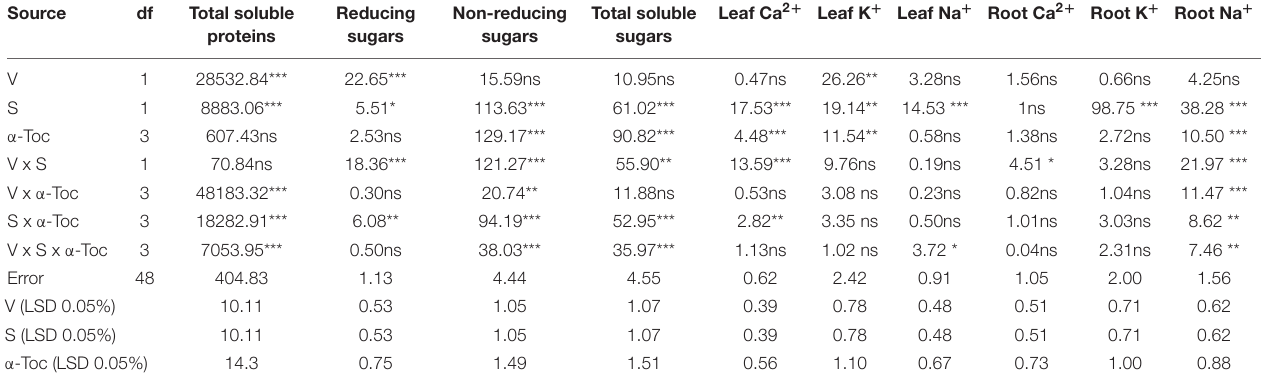
TABLE 3 | Analysis of variance (mean squares) for leaf gas exchange attributes of okra plants treated with α -tocopherol as foliar spray under saline and non-saline conditions. Source